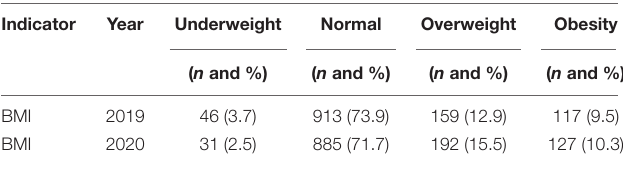
TABLE 1 | BMI rank